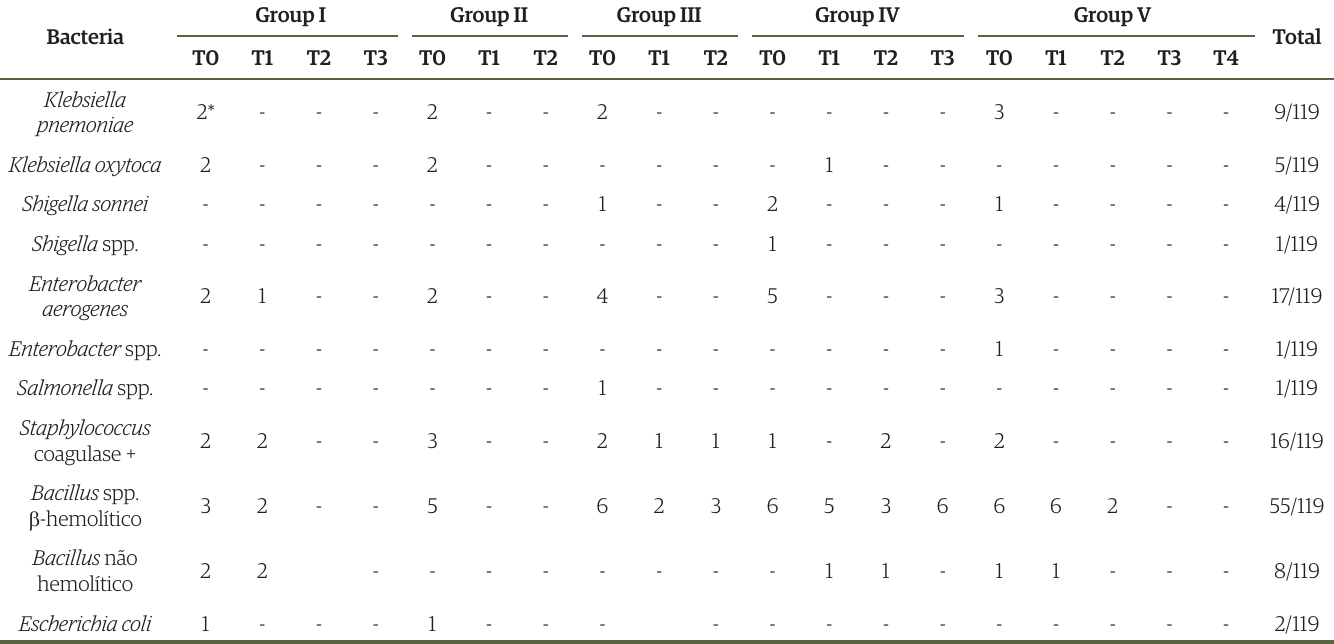
Table 4. Bacteria isolated from cutaneous swabs in the surgical field of bitches submitted to elective ovariohysterectomy (OVH) at different times called T , T , T , T , and T . 0 1 2 3 4